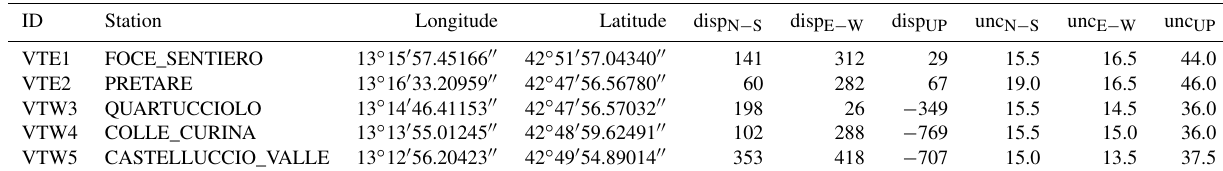
Table 1. Three-component co-seismic displacements and relative uncertainties estimated for the GNSS stations of the UNICT network. Coordinates are WGS84 east and north, respectively. All displacement and uncertainty values are in millimetres. For all stations, the cut-off angle is 15 ◦ , the troposphere model is the Goad–Goodman and the meteorological model used is NRLMSISE-00. The table can be download as an ASCII file on the INGVRING web page (http://ring.gm.ingv.it).